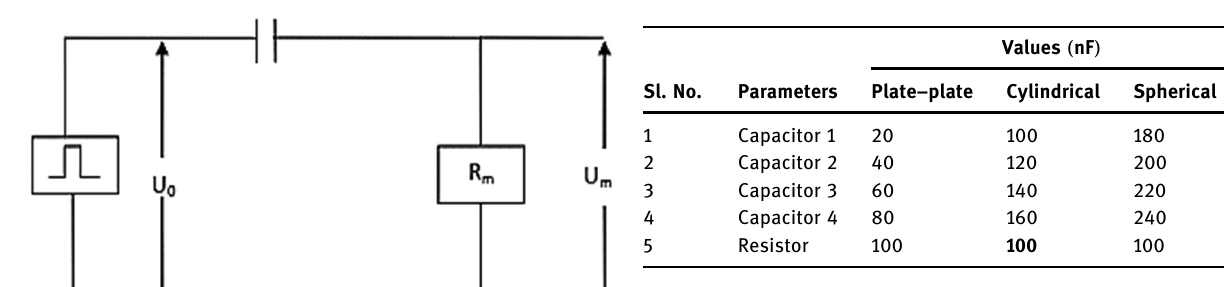
Table 2: Switching capacitors used in Proteus simulation